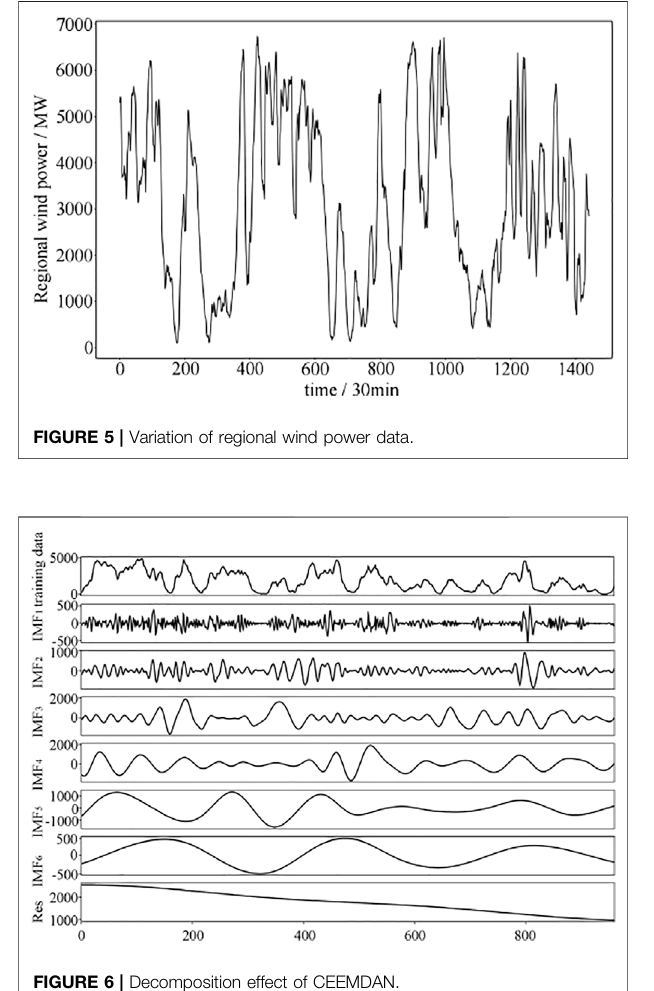
FIGURE 6 | Decomposition effect of CEEMDAN.